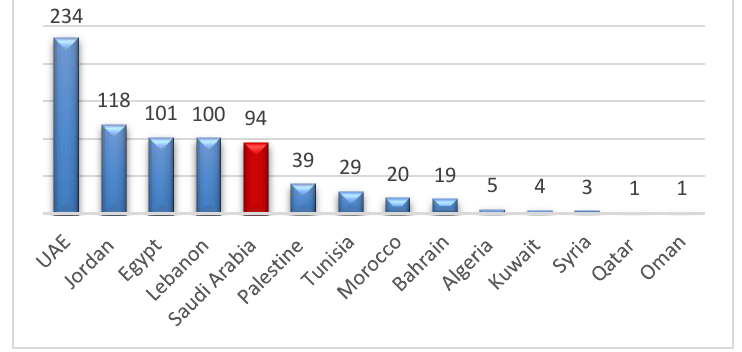
Figure 1: Number of Investments in Saudi Arabia Versus MENA; Source: ArabNet (2017): KSA Innovation Economy Report: Tech